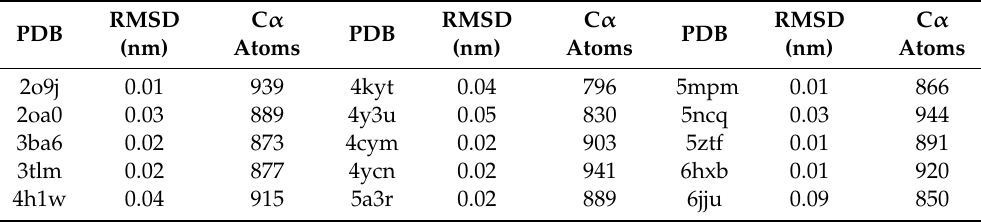
Table A2. Root-mean-square distance (RMSD) of the C α atoms between the SERCA1a models and the incomplete crystal structures.